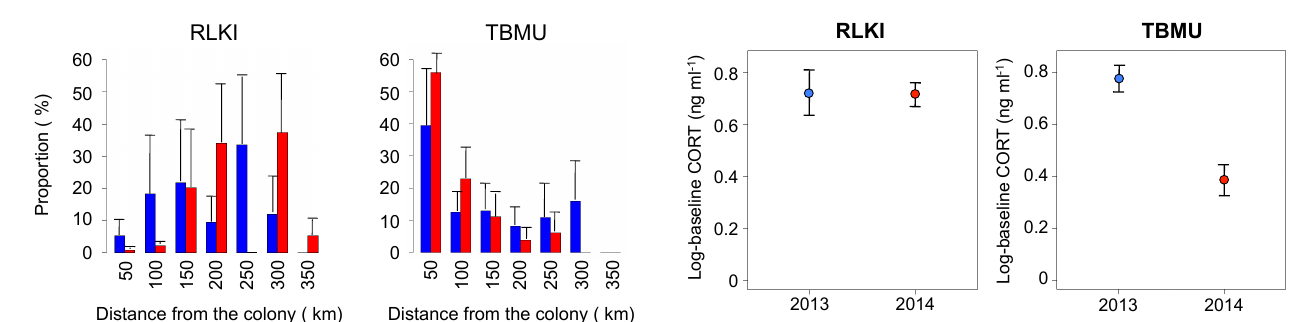
Figure 3. The straight-line distances between the colony and on- water locations of red-legged kittiwakes (RLKI) and thick-billed murres (TBMU) in 2013 (blue bars) and 2014 (red bars). The mean and standard error are presented.